Question: Provide a one-line summary of what is displayed.
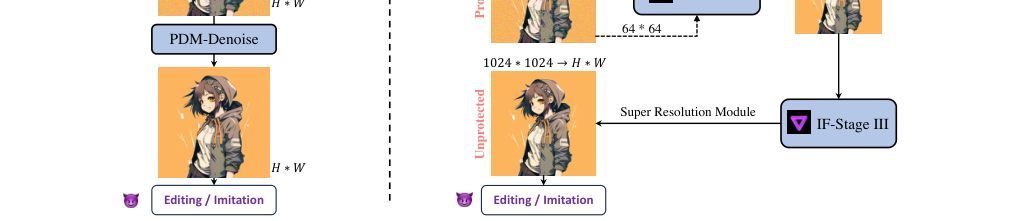
Answer: PDM-Pure is Easy to Design: (a) PDM-Pure applies SDEdit [24] in the pixel space: it first runs forward diffusion with a small step t∗and then runs denoising process. (b) We adapt the framework to DeepFloyd-IF [38], one of the strongest PDMs. PDM-Pure can effectively remove strong protective perturbations (e.g. δ = 16/255). The images we tested are sized 512 × 512.